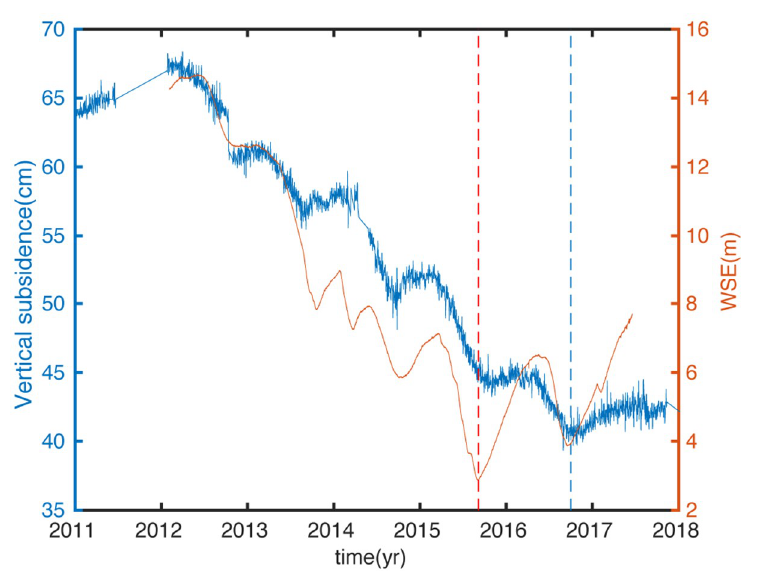
Figure 11. Comparison of vertical subsidence time series at GPS station ALTH (blue line, left axis) versus water surface elevation (WSE) at the co‐located well 12S12E16H005 (orange line, right axis). The orange dashed line indicates the time when the water level starts to recover. The blue dashed line is the time that the secular subsidence ceases.